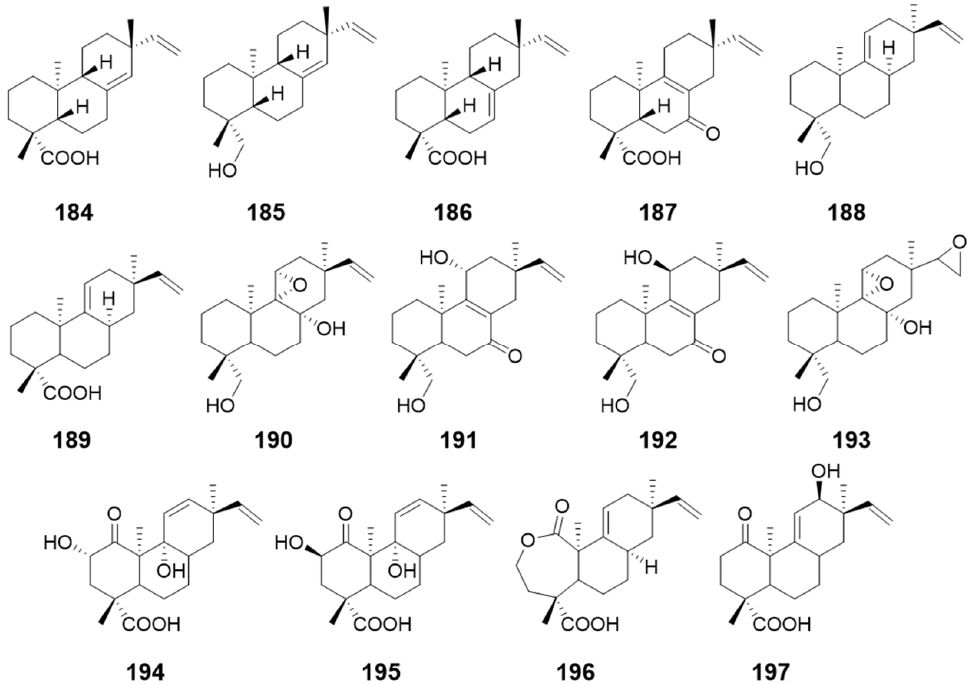
Figure 19. Structures of compounds 184 – 197 .